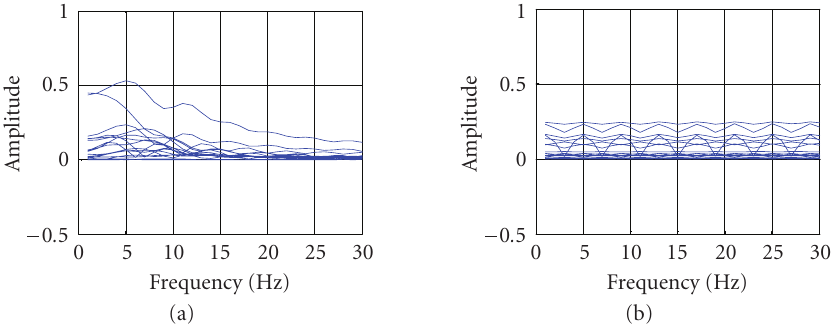
Figure 5.3 . (a) The spectrum of a whitened EEG noise by AR Yule-Walker, (b) the spectrum of a whitened EEG noise by AR-FBLP.